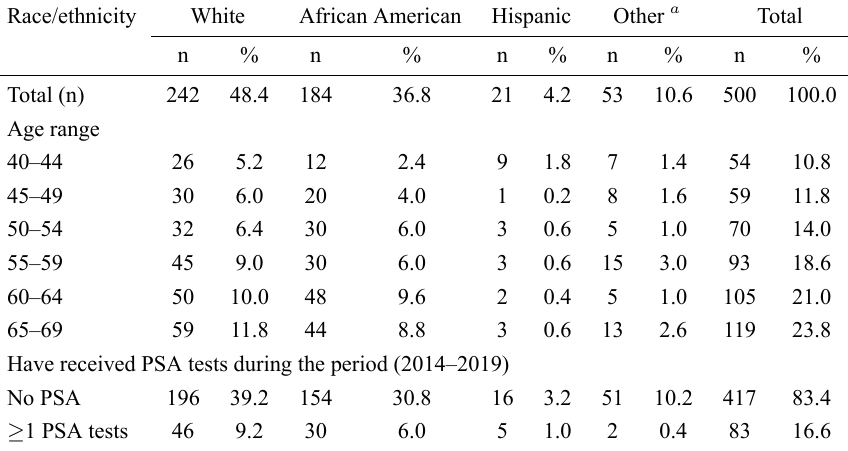
Table 1. Demographics of male patients in the sample (n =